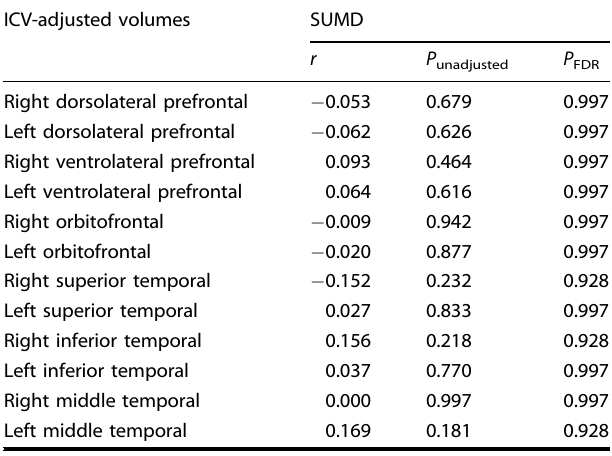
Table 3. Correlations between ICV-adjusted volumes and SUMD in SZH (controlling for duration of illness, education and